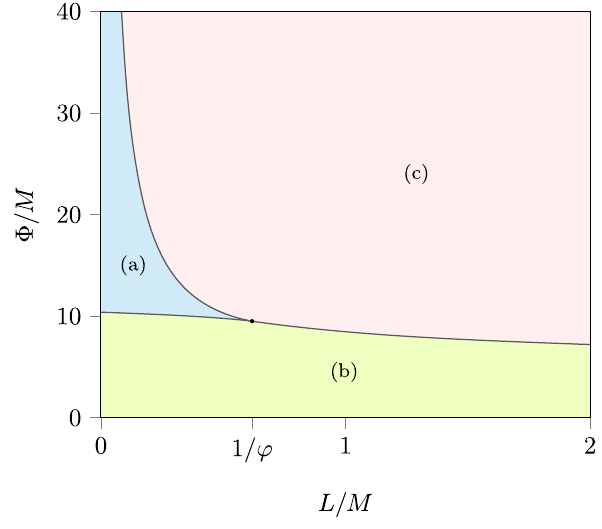
Fig. 14 The three different parts, a – c , of the L – (cid:9) parameter space, whose level curves exhibit the three topologically distinct types of behaviour as shown in Fig. 13a, b and c, respectively. The three bound- ary curves all meet at the critical point (black dot), where L = M /ϕ (cid:11) 0 . 618034 M and (cid:9) (cid:11) 9 . 51057